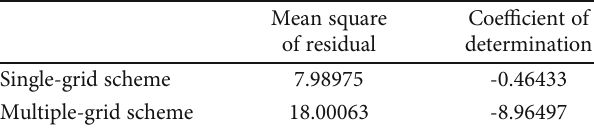
Table 2: The K-C theoretical curve fi tting statistics. Mean